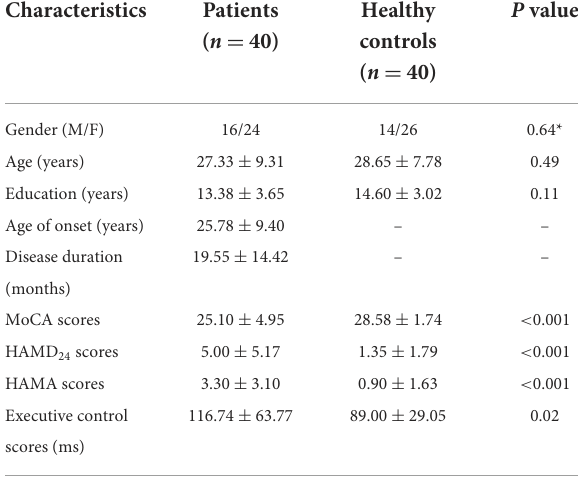
TABLE 2 Comparison of demographic details and neuropsychological tests data between the Patients and healthy